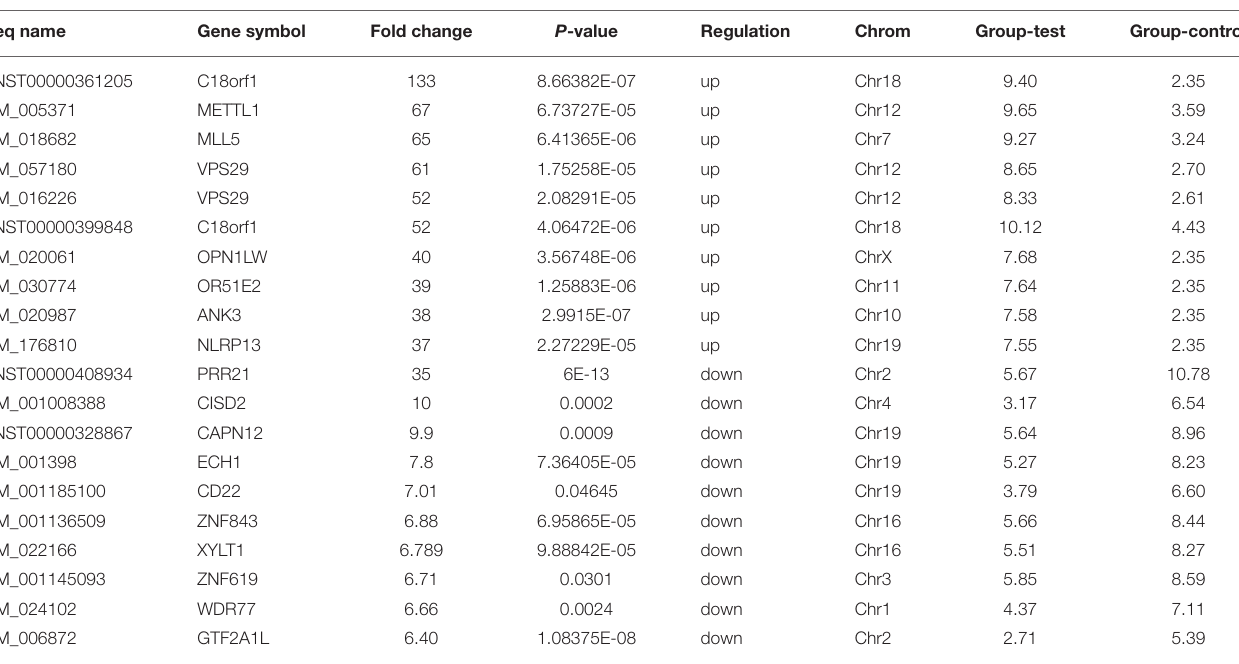
TABLE 4 | Differentially expressed